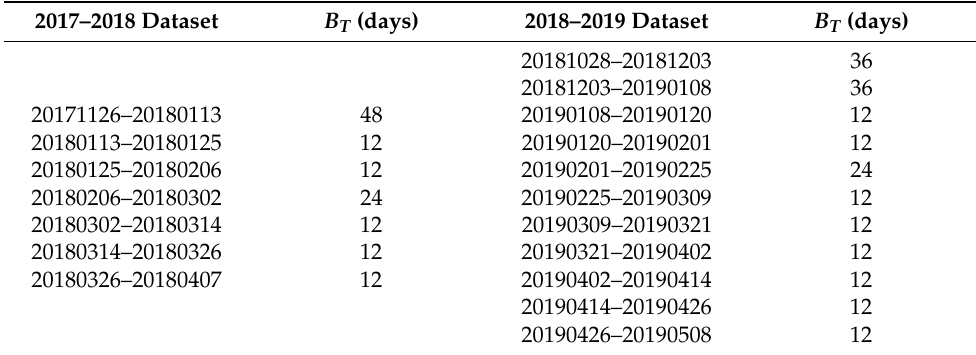
Table 1. Sentinel-1 SAR datasets for 2017–2018 and 2018–2019 annual cycles 1